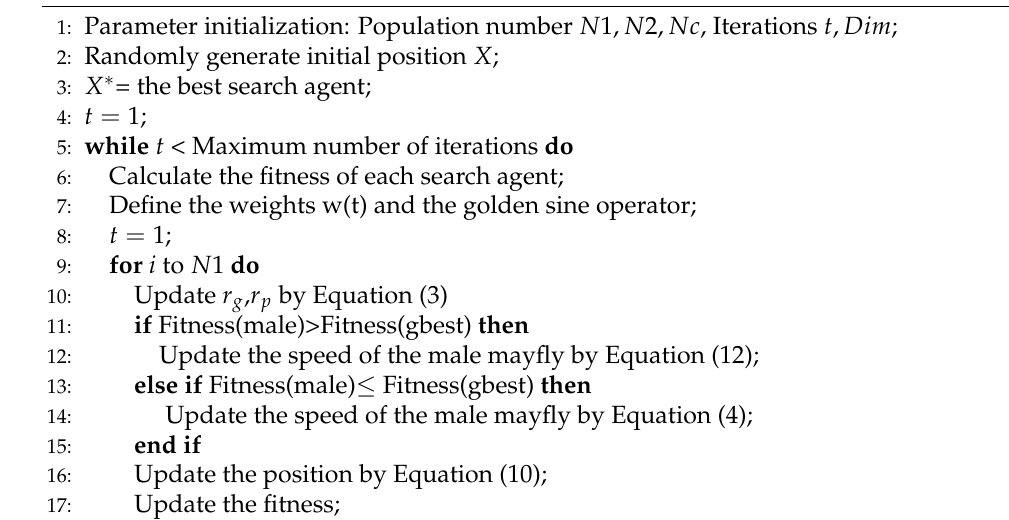
Algorithm 1 improved mayfly optimization